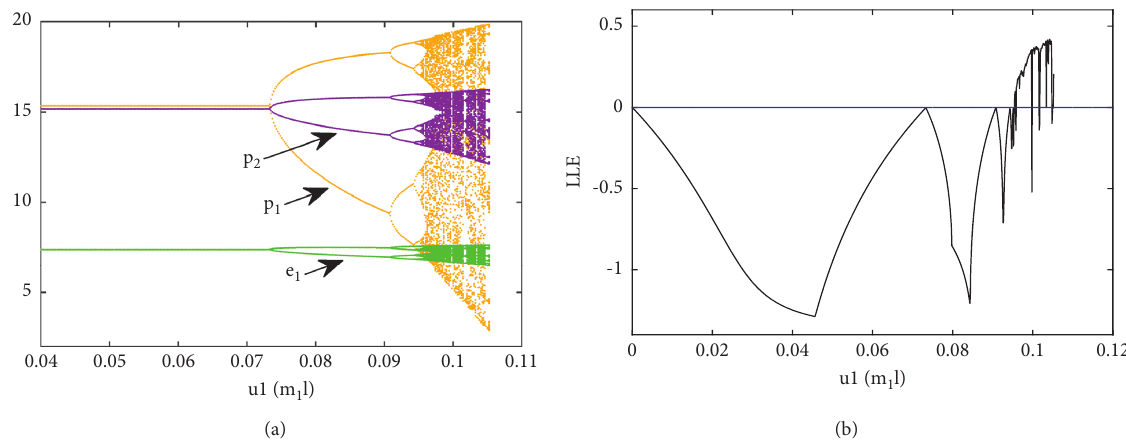
Figure 5: (a) Bifurcation diagram and (b) LLE of the system (23) with varying u